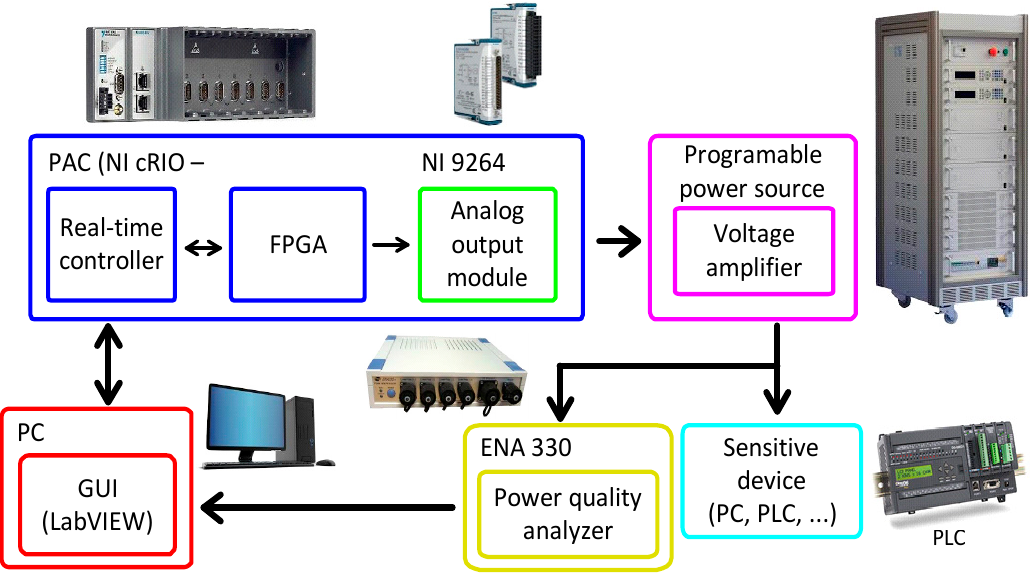
Figure 9. Structure of the voltage sag sensitivity test stand.